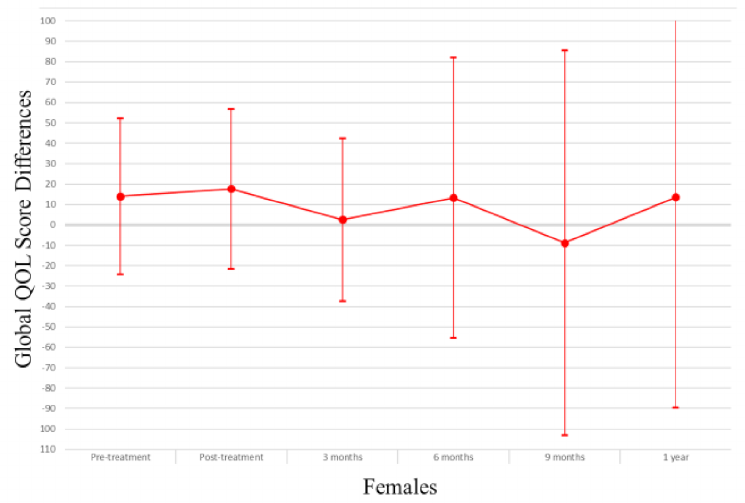
Figure 3. Global QOL score differences in female study population. In the overall sample (Table 3), those with myosteatosis had global QOL scores 21.97 points lower than those with normal SMD at 9 months post treatment ( p = 0.02). After adjustment, just post treatment an improved global QOL score emerged for those with myosteatosis ( β 10.67, p = 0.02).Among men, global QOL scores were 21.64 points lower in those with myosteatosis at nine months post-treatment ( p = 0.02) and 54.64 points lower at one year post-treatment ( p = 0.02). After adjusting for age, body mass index, mus- cle mass, total adipose tissue, cancer stage, site and treatment, KPS, partner status, smoking status, and alcohol consumption status those with myosteatosis averaged 57.57 points lower at one-year post treatment ( p = 0.01). For a visual representation of the adjusted models for physical QOL score differences between those with myosteatosis and those with normal musculature, see Figures